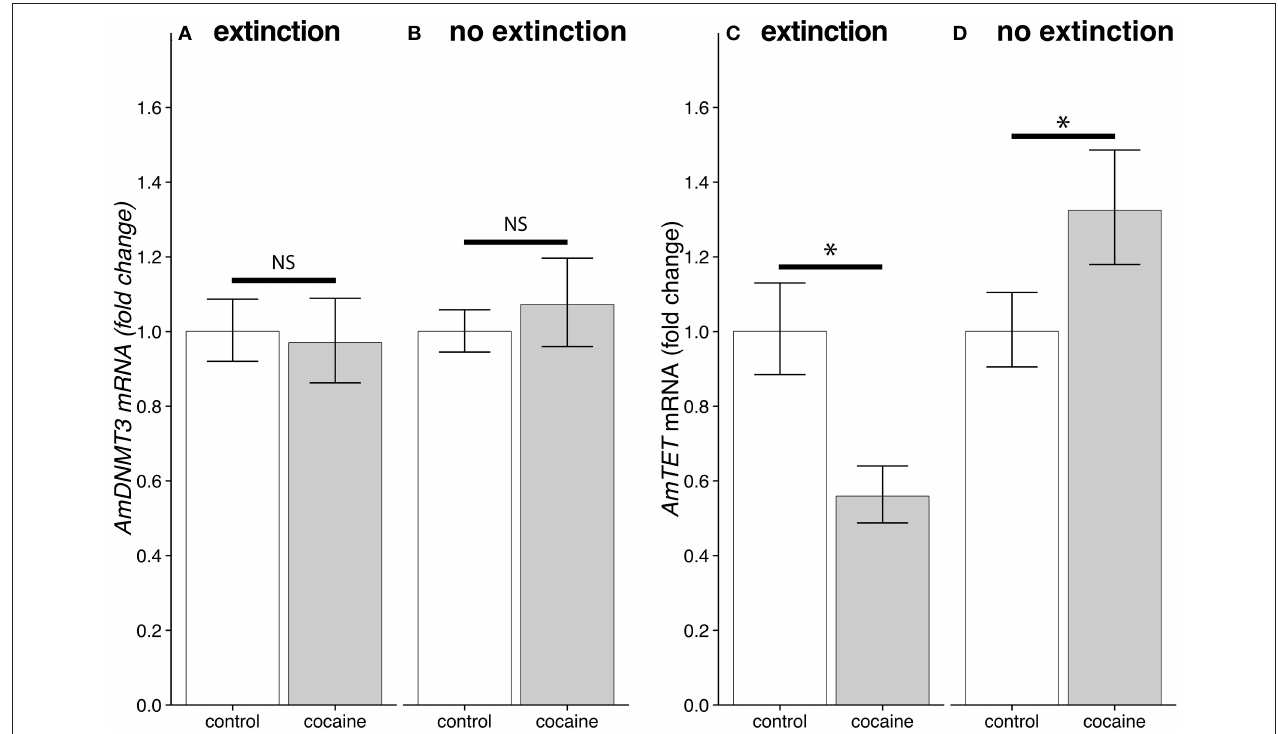
FIGURE 7 | The effects of cocaine and extinction training on levels of DNA methylation enzymes 1h after treatment. (A) There was no significant difference in AmDNMT3 mRNA levels following cocaine or control treatments given after extinction training ( AmUGT : t 10 = 0.8532, p = 0.4135; AmeIF.S8 : t 10 = − 0.6977, p = 0.4927). (B) Similarly, levels were not affected by cocaine in bees that did not go through extinction training ( AmUGT : t 10 = 0.9113, p = 0.3836; AmeIF.S8 : t 10 = 1.8837, p = 0.0729). (C) There was a significant reduction in levels of AmTET mRNA in bees treated with cocaine following extinction training ( AmUGT : t 10 = − 3.6832, p = 0.0013, d = − 1.1105; AmeIF.S8 : t 10 = − 7.8450, p < 0.0001, d = − 2.3653). (D) Intriguingly, bees that only went through acquisition training, prior to being treated with cocaine showed the opposite effect ( AmUGT : t 10 = 14.1652, p < 0.0001, d = 4.2710; AmeIF.S8 : t 10 = 6.9097, p < 0.0001, d = 2.0834). *Denotes statistically significant differences.